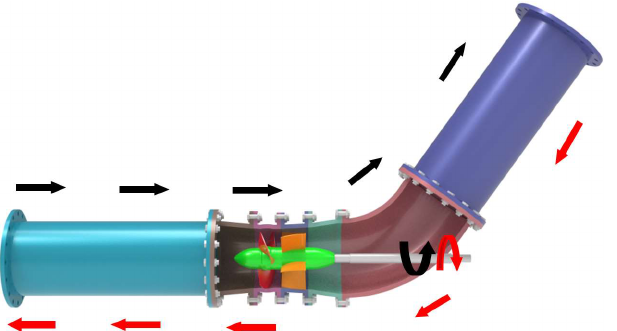
Figure 3. Schematic diagram of forward and reverse operation of “S” shaped airfoil bidirectional axial flow pump. (Black indicates forward operation, Red indicates reverse operation).